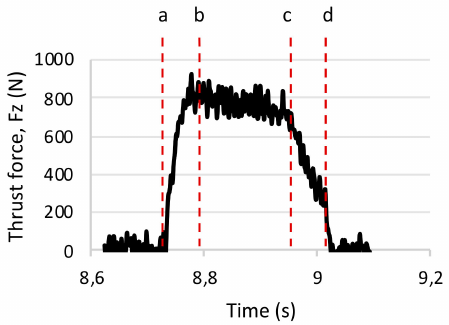
Figure 5. Thrust force evolution over time for a peck-drilling